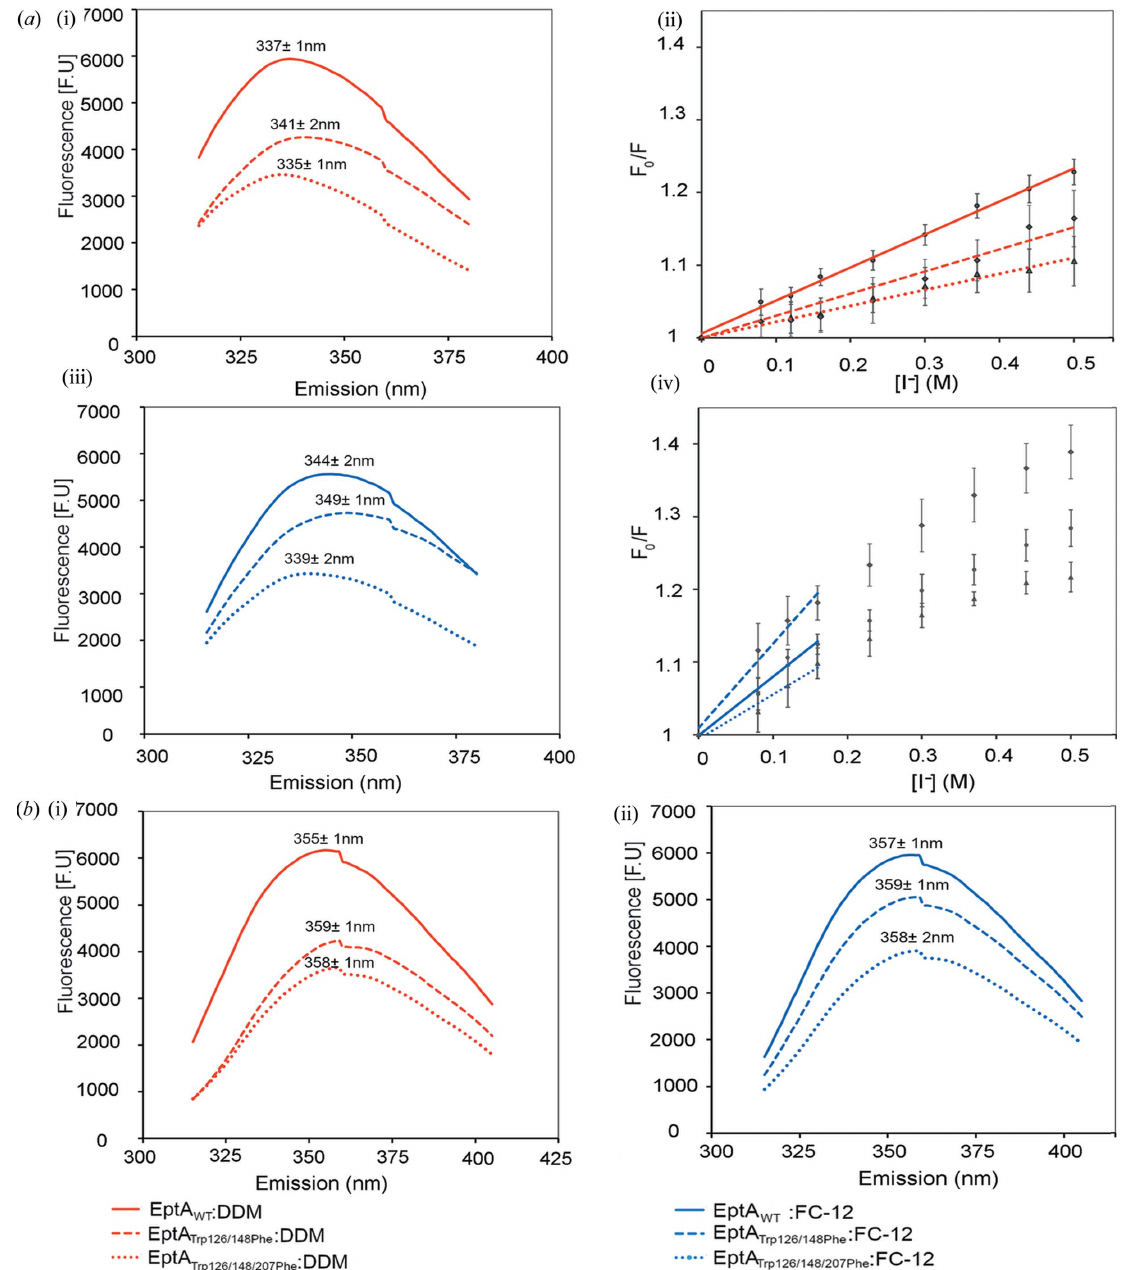
Figure 5 Intrinsic fluorescence spectra and quenching profiles for EptA in different detergent micelles. ( a ) Fluorescence spectra and Stern–Volmer plots for native folded enzyme and ( b ) fluorescence spectra for the denatured enzyme. The emission wavelength maxima ( (cid:4) max ) for each condition are indicated above each curve. The red and blue coloured lines represent enzyme in DDM and DPC micelles, respectively. The solid lines represent EptA WT , the dashed lines represent EptA Trp126/148Phe and the dotted lines represent EptA Trp126/148/207Phe . Panels (i) and (iii) show the emission spectra of the enzymes and panels (ii) and (iv) in ( a ) show the Stern–Volmer plot for quenching using iodide. A linear regression was fitted using GraphPad prism with an R 2 value above 0.95. Where a non-linear relationship was observed, only the initial linear slope was